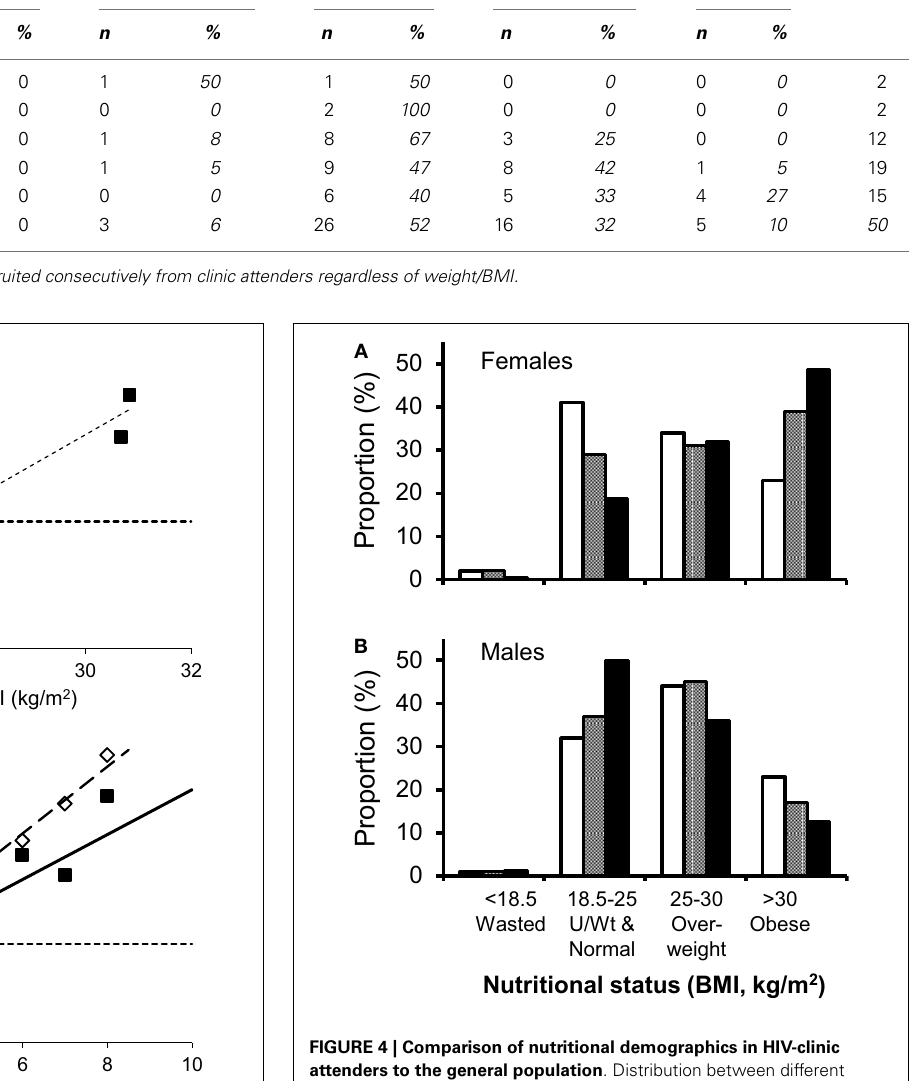
our cohort ( P = 0.56), or in HSE, where obesity rates in black African men were lower than the general population (17 versus 22%)(38). Itmightbearguedthatdatafrom 2004donotrepresent